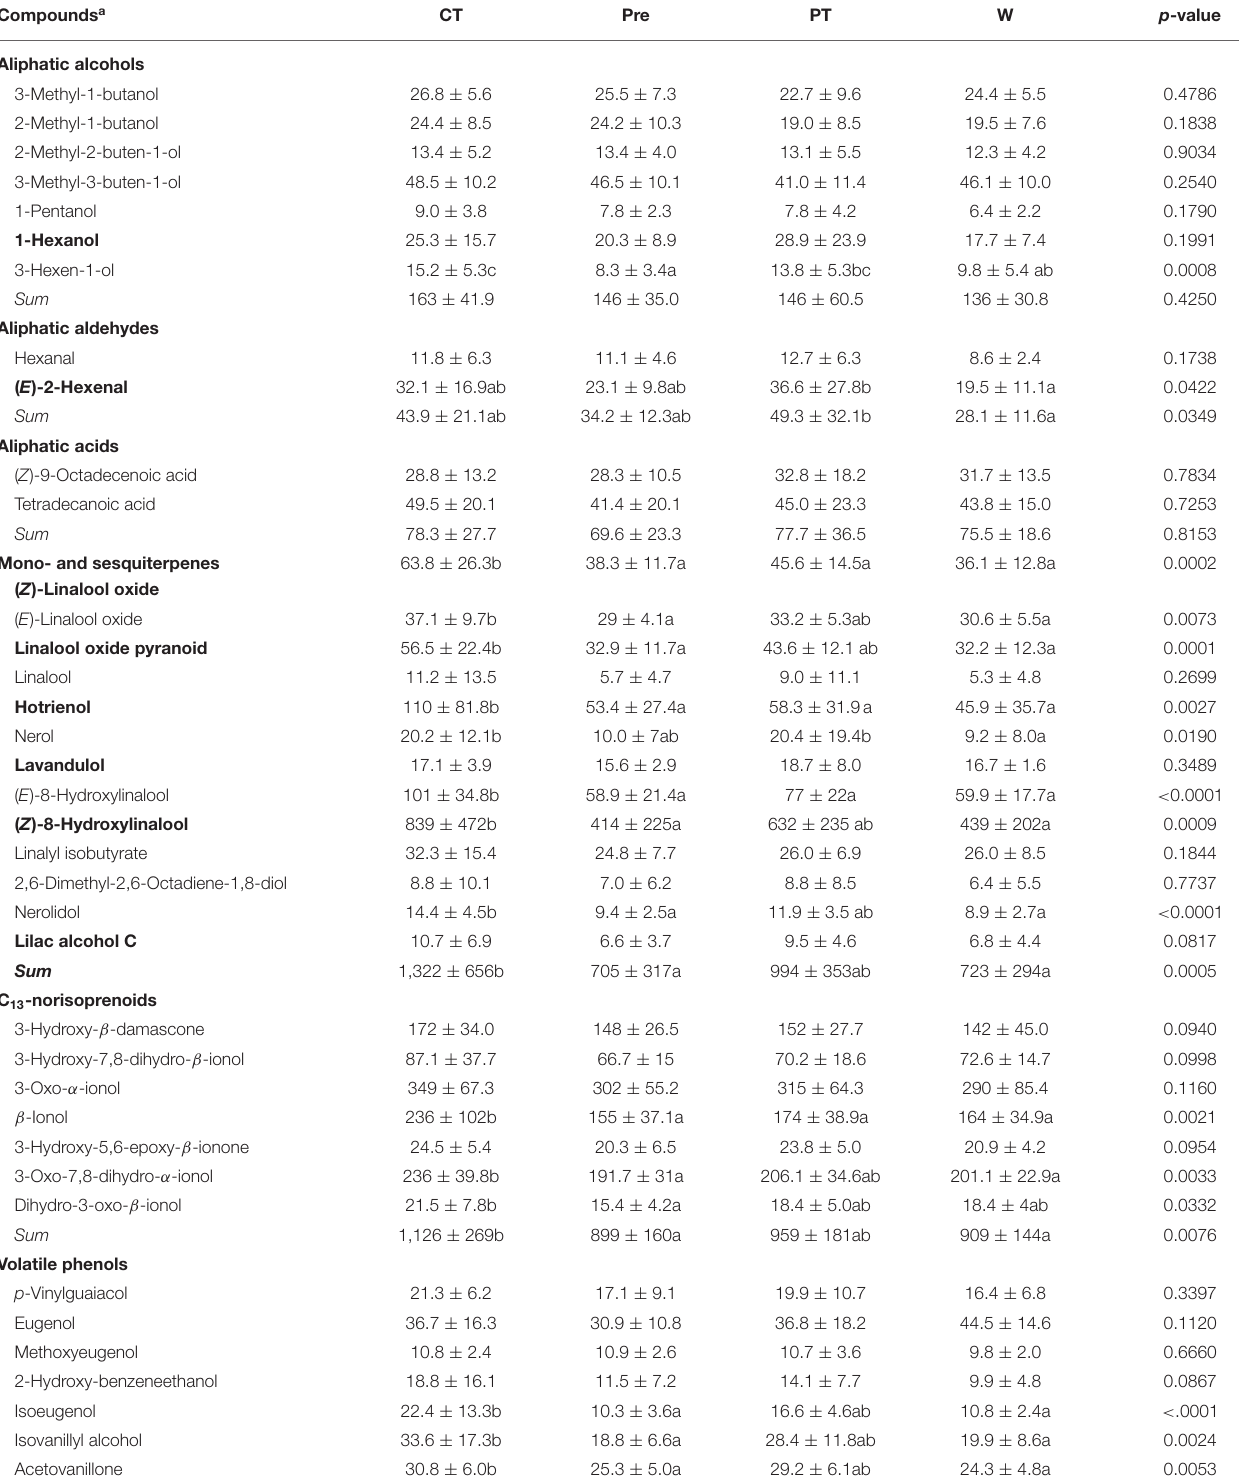
TABLE 4 | Impact of the temperature treatments (Control; Pre, pre-veraison; Post, post-veraison; Whole, whole season) on the profile of glycosylated volatile compounds (ng · g − 1 FW) of berries from Vitis sp. cv. L’Acadie blanc in 2020. Compounds a CT Pre PT